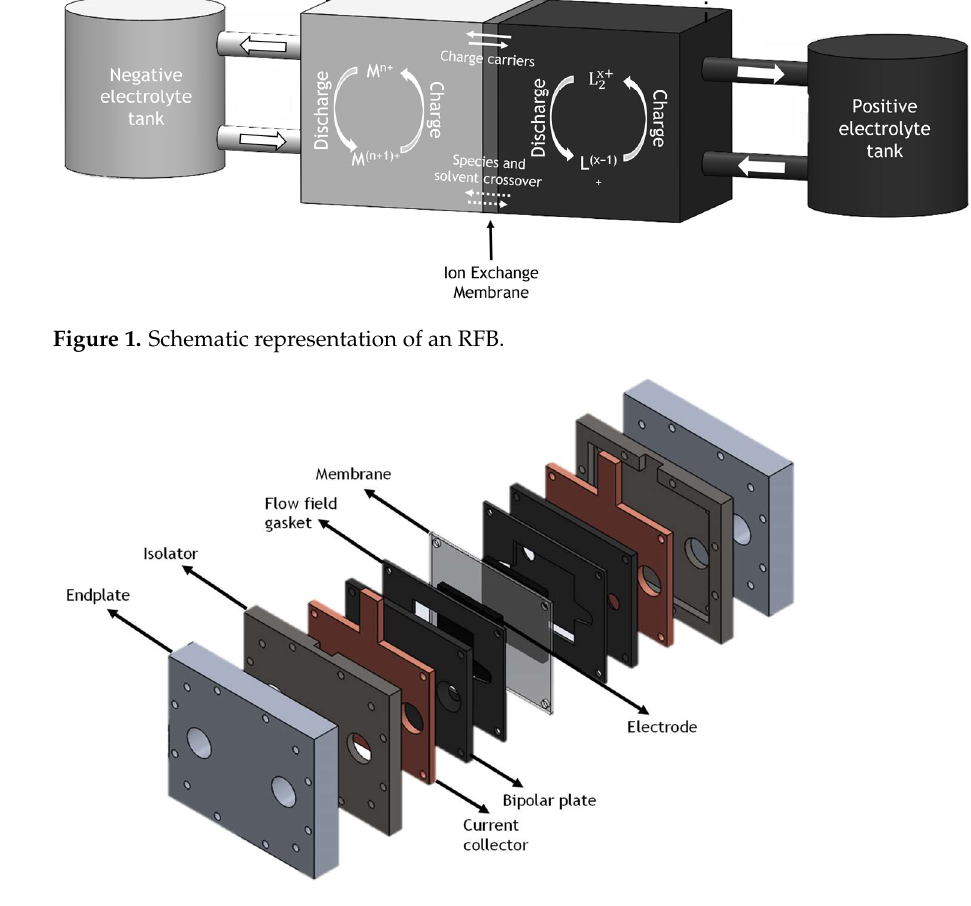
Figure 1. Schematic representation of an RFB.